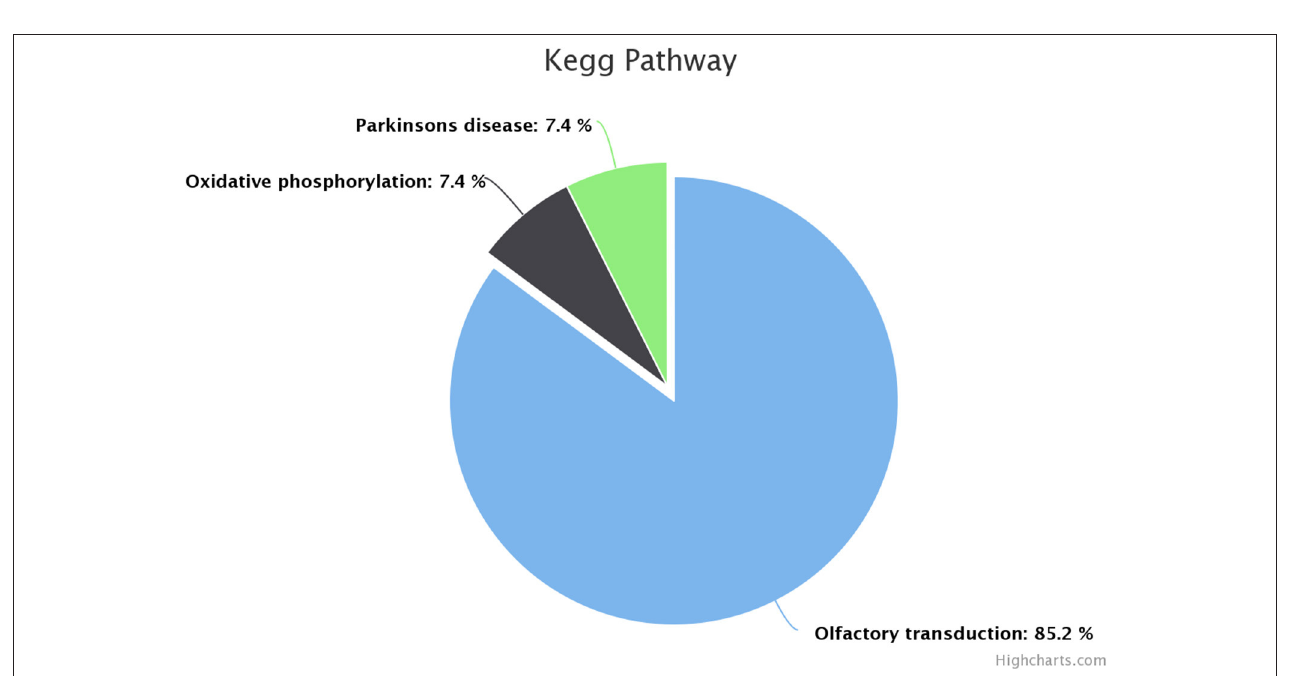
Frontiers in Veterinary Science |